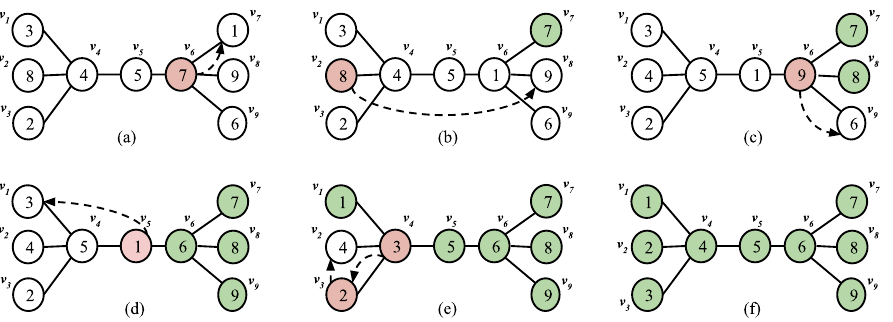
Figure 5. Illustration for Algorithm A db . ( a ) S R Swaps = 1. ( d ) S R homed. Total Swaps =